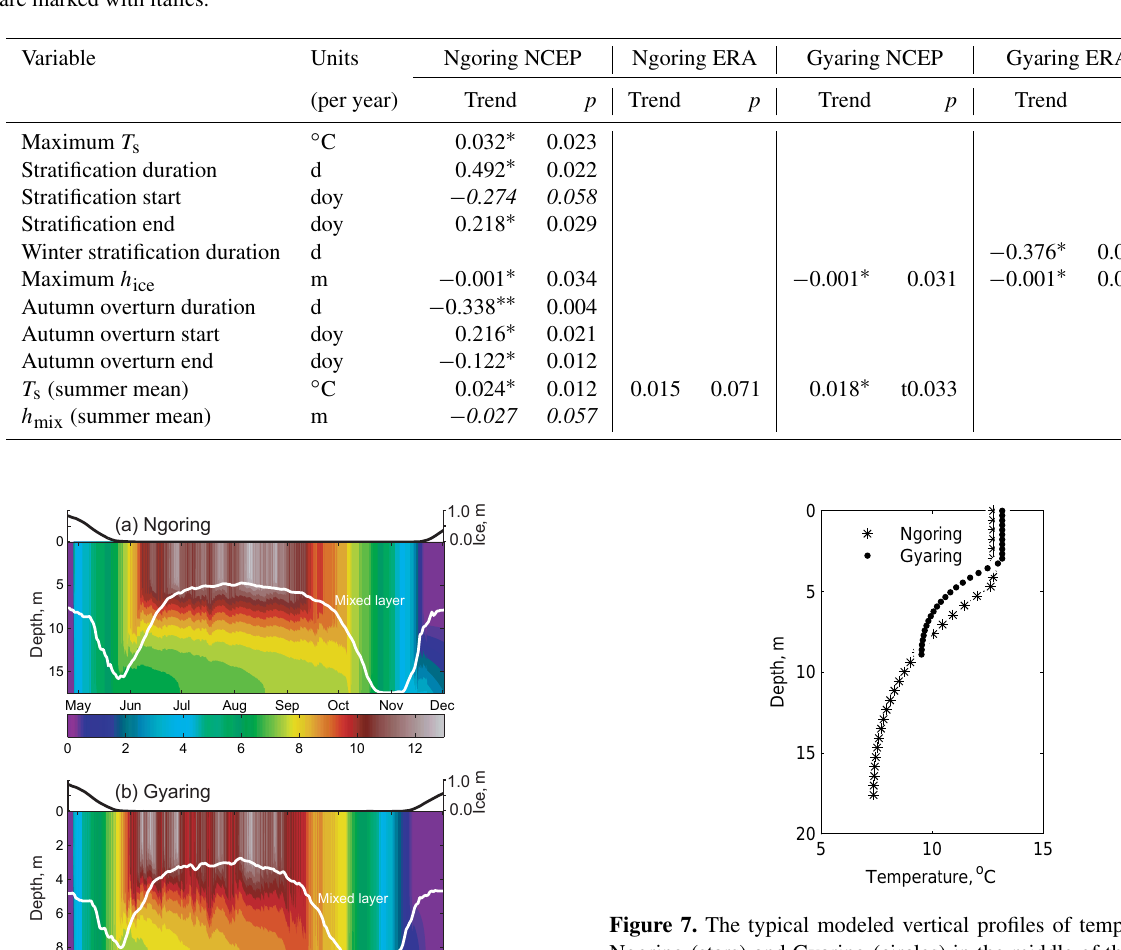
Table 4. The trends in the characteristics of the lake thermal regime; abbreviations as for Table 2. Marginally significant trends (0 . 05 < p < 0 . 1) are marked with italics.